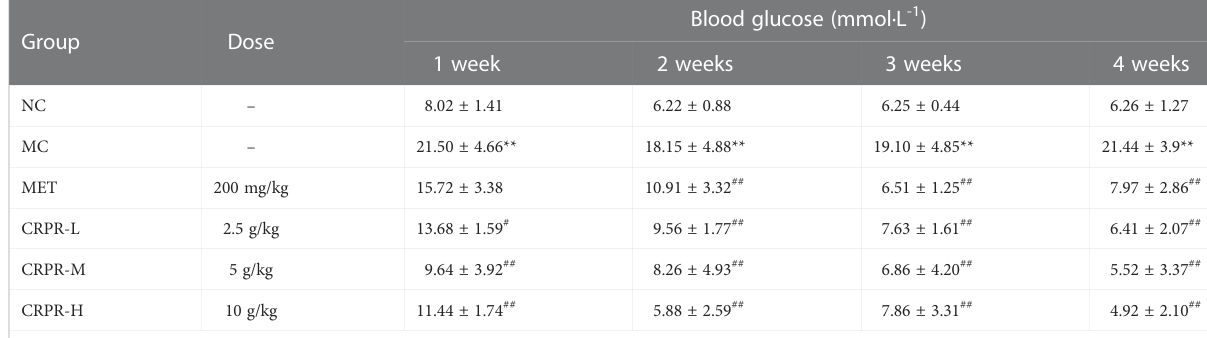
TABLE 2 Effect of CRPR on blood glucose concentration in T2DM